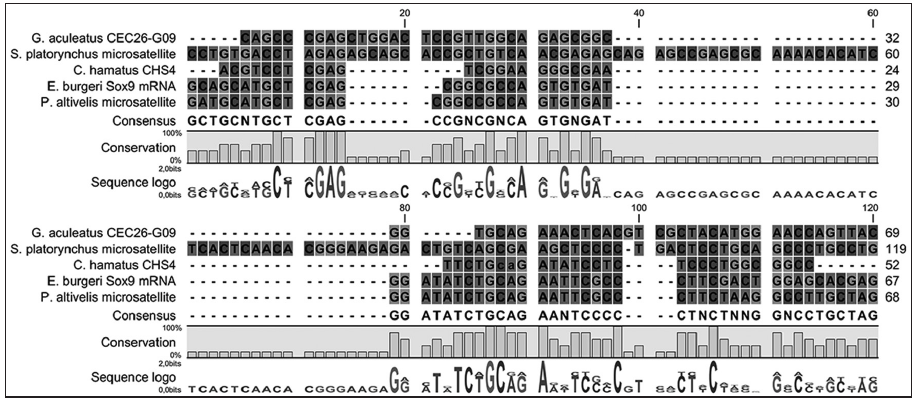
Figure 3. Repetitive sequence of clone CHS4 aligned with several loci of Plecoglossus altivelis , Gasterosteus acu- leatus , Scaphirhynchus platorynchus and Eptatretus burgeri . Notably, in E. burgeri the sequence is found in